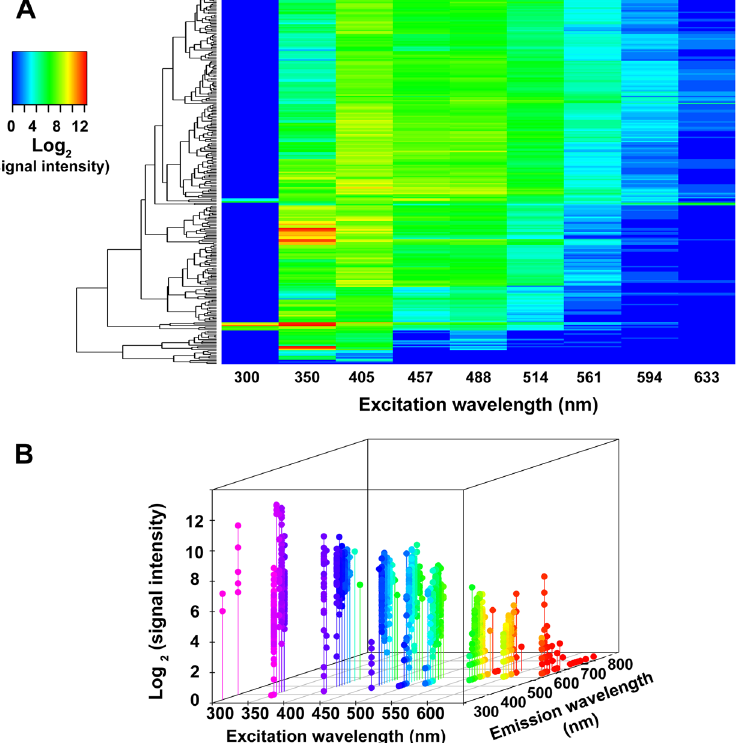
Figure 2. E-liquids have unique autofluorescence profiles. ( A ) Heatmap of Log 2 (signal intensity) for all e-liquids, clustered by similarity in autofluorescent profile. ( B ) 3D scatterplot showing the emission wavelength and Log 2 (signal intensity) for all